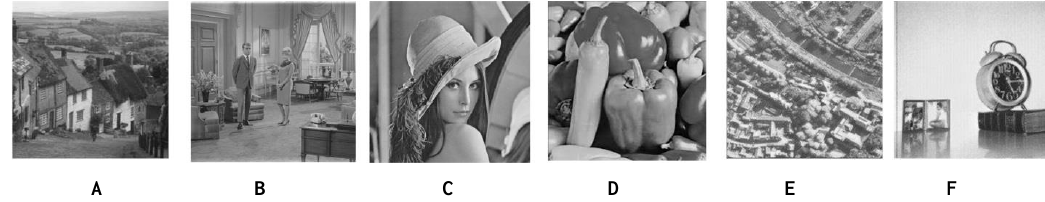
Figure 3: Various Host Images taken (A) Goldhill (B) Couple (C) Lena (D) Peppers (E) Aerial (F) Clock.